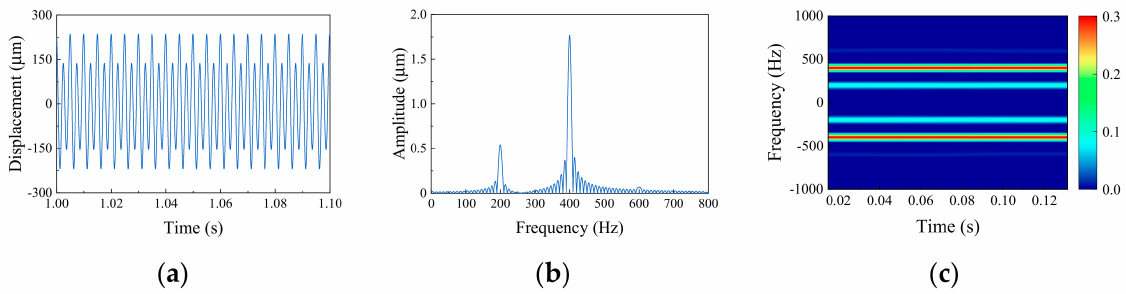
Figure 11. Comparison of fault signal processing results: ( a ) time domain diagram; ( b ) frequency domain diagram; ( c ) time-frequency diagram.